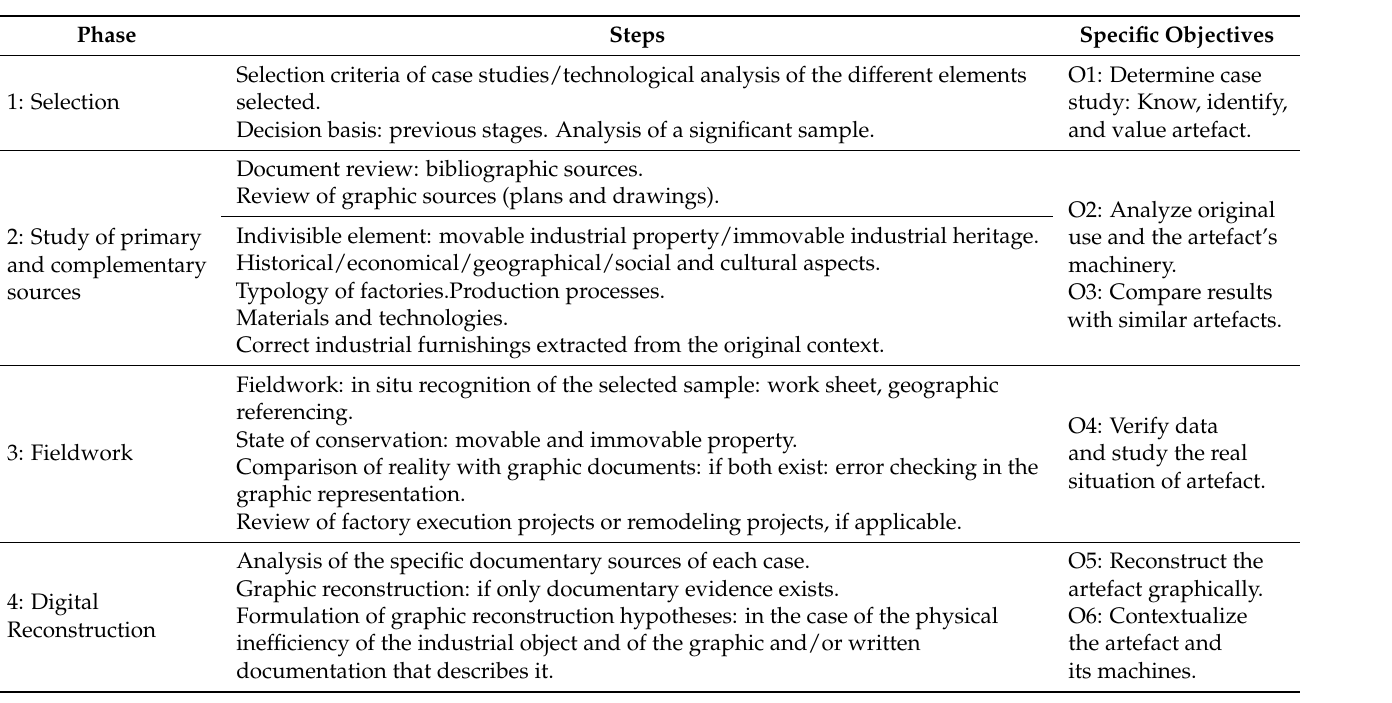
Table 1. General methodology. Source: own